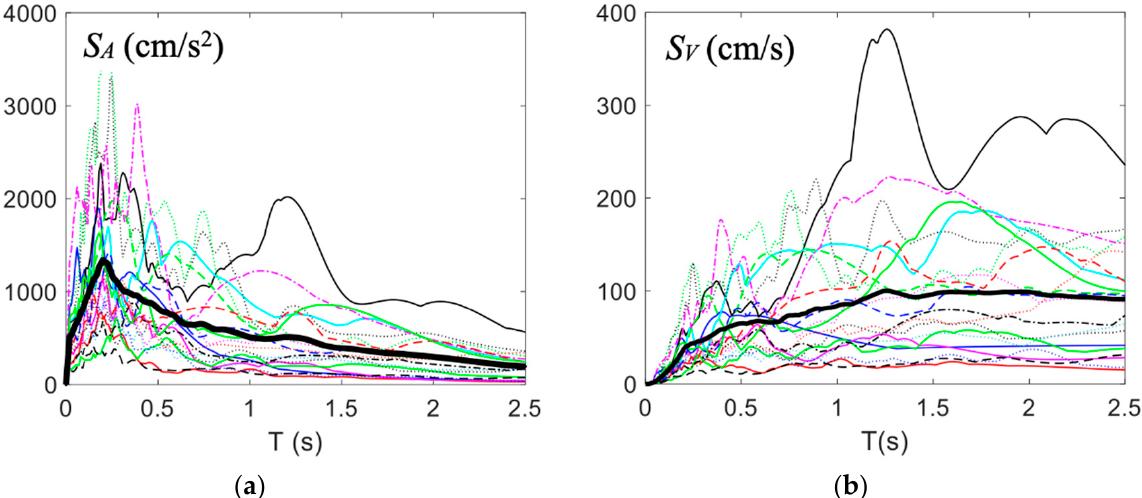
Figure 5. S V -T : Unscaled response spectra in terms of S A ( a ) and S V ( b ).